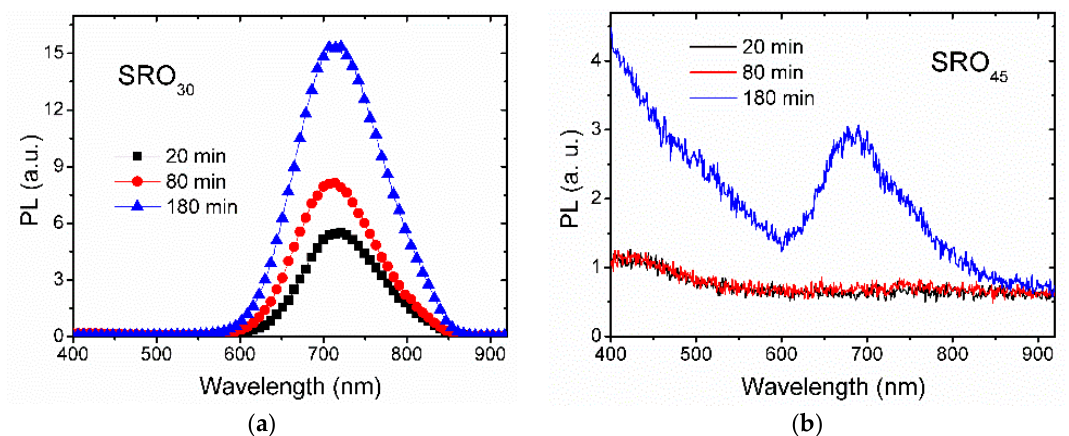
Figure 2. ( a , b ) Photoluminescence spectra of SRO 30 and SRO 45 films, respectively, for three different annealing times at 1100 °C.